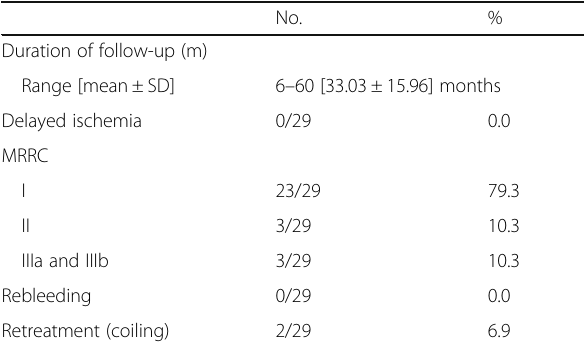
Table 4 Long-term follow-up